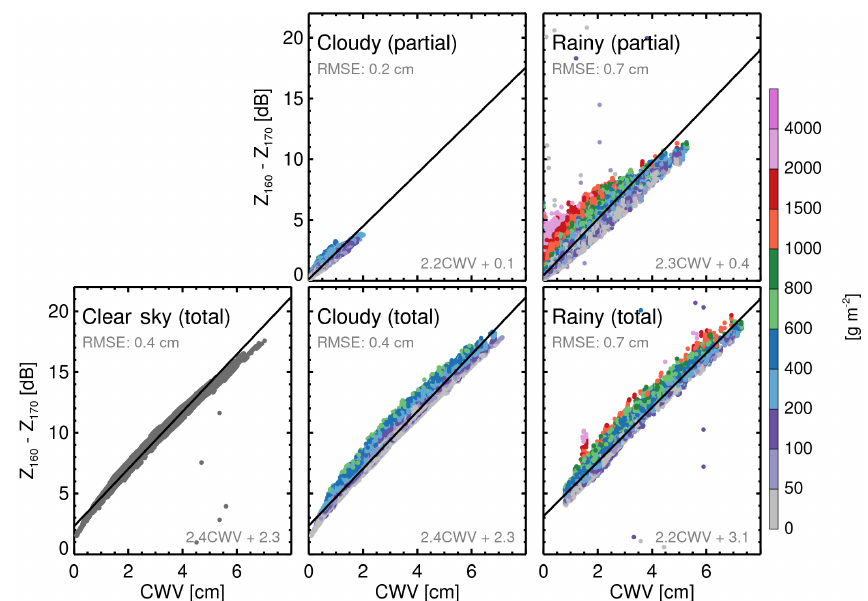
Figure 3. Simulated relationships between surface radar returns and total and partial CWV. Each point represents a CloudSat-driven simula- tion for each of the CloudSat measurements available from 15 January 2007. The total or partial hydrometeor column is color-coded. Dark gray is used for clear sky cases (total hydrometeor column equal to zero). The black line shows the linear regression. The root mean square error (RMSE) displayed is the overall linear regression error for each scenario. The top row shows the relationship between the range-gated radar returns and partial CWV and the bottom row displays the relationship between the surface returns and total CWV.